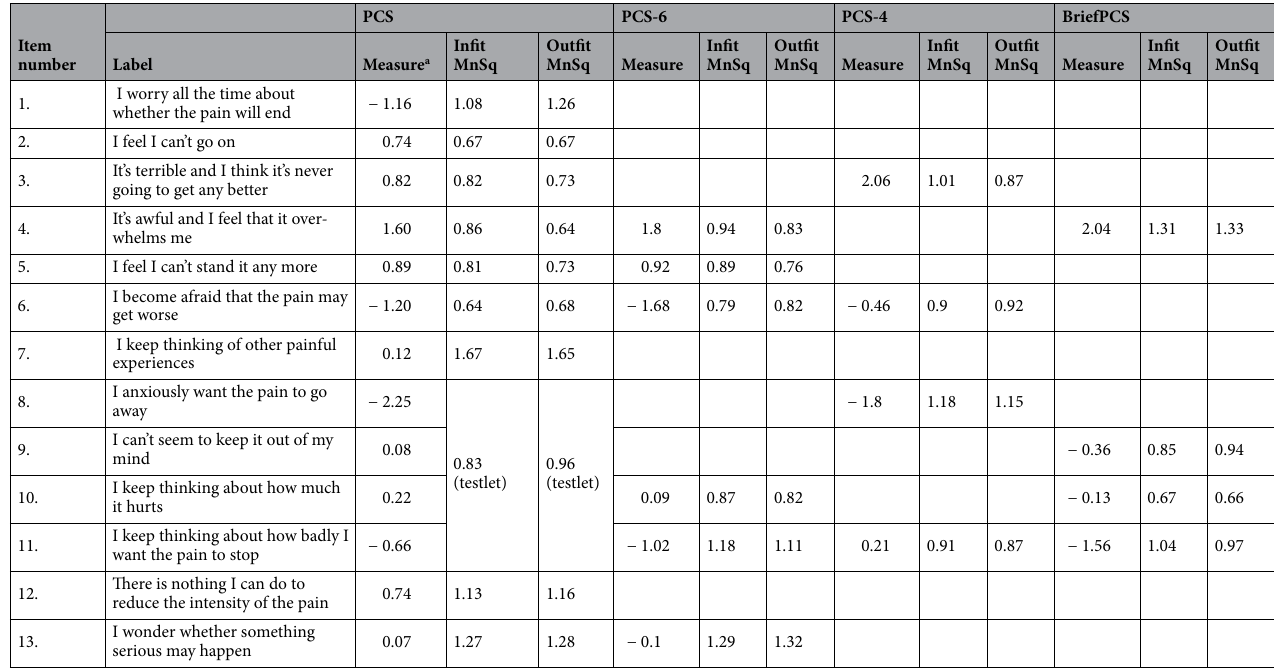
Table 1. Item calibrations (Measure) and fit information—expressed as infit and outfit mean square statistics (MnSq)—for the PCS and its three short forms. a Item calibration before testlet creation (items